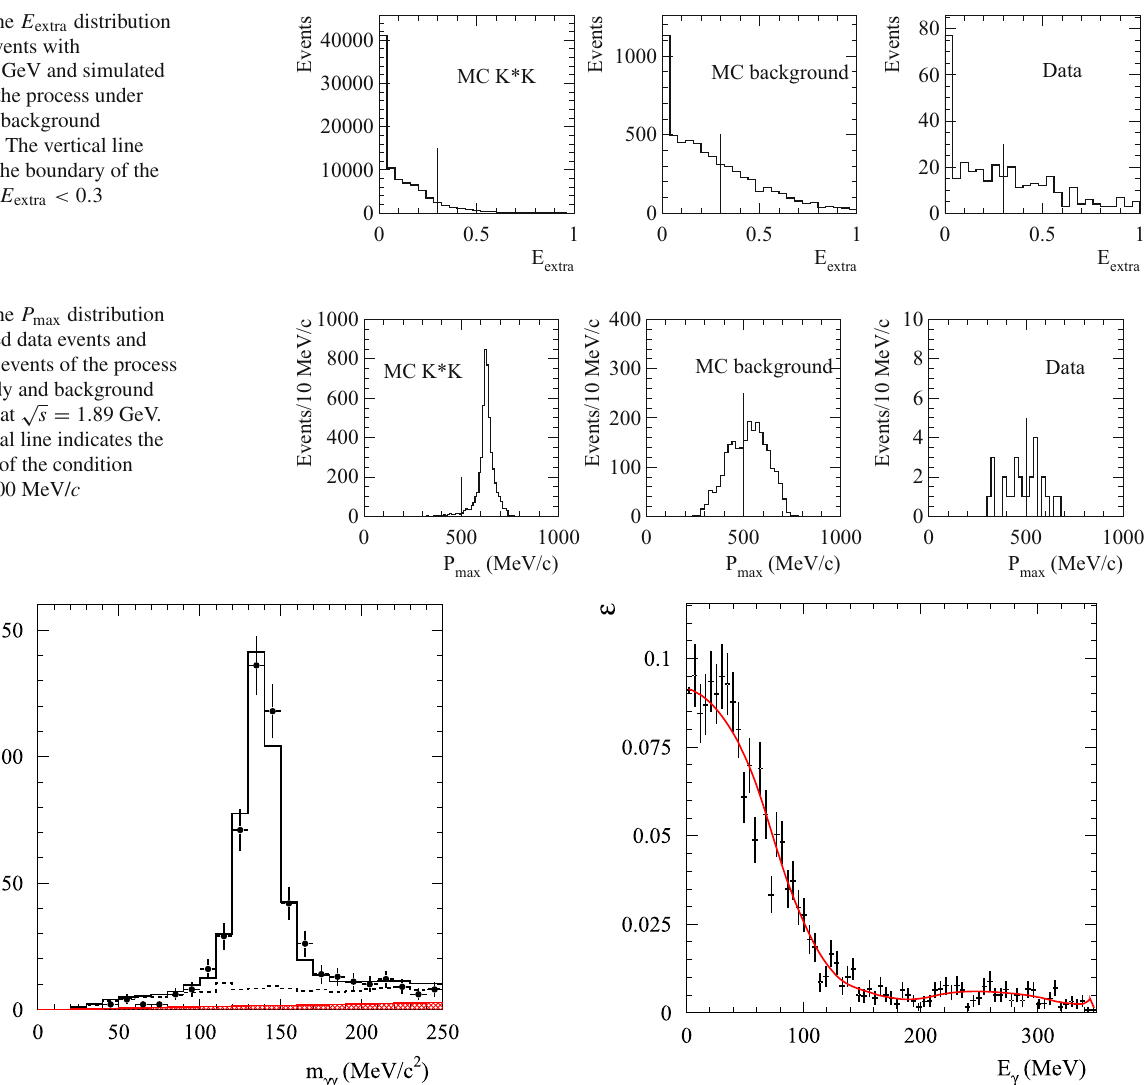
Fig. 6 The dependence of the detection efficiency for e + e − → √ K + K − π 0 events at s = 1 . 575 GeV on the energy of the photon emitted from the initial state. The dependence is approximated by a smooth